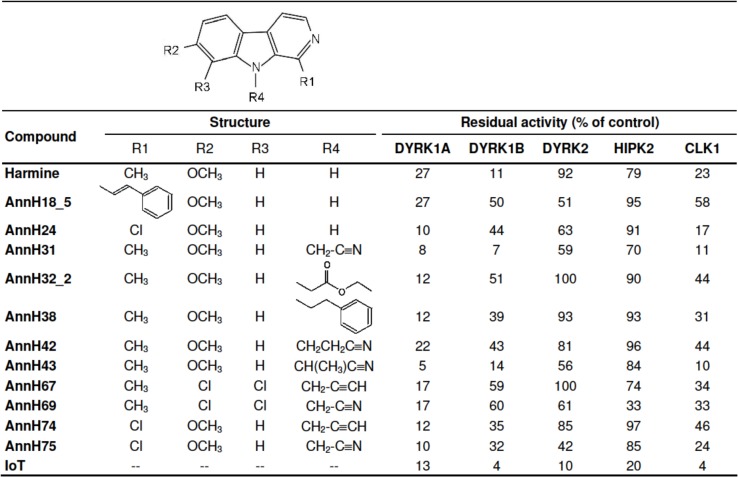
Inhibition of DYRK1A and related kinases by selected β-carbolines.Kinase activities are given as the means of at least 3 measurements in the presence of 1 μM of the compounds (10 μM in HIPK2 assays) and are expressed as the percentage of the uninhibited control (Kinase-GLO assay). 5-iodotubercidin (IoT) served as a structurally unrelated control compound that inhibits all tested kinases.